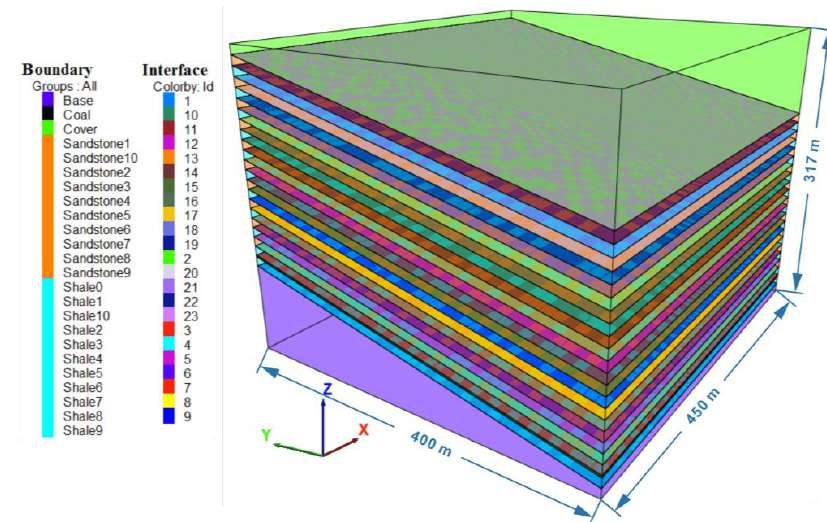
Figure 15. A three dimensional model for optimizing the advance direction for longwall mining along dip.